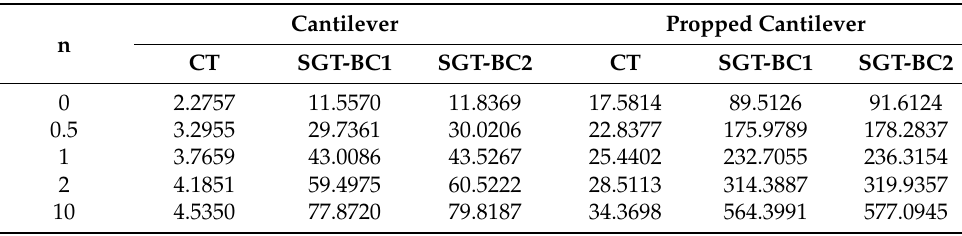
Table 4. Dimensionless buckling loads for nonhomogeneous tapered microbeams for various gradient indices ( α = 0.25, l L = h 1 ).